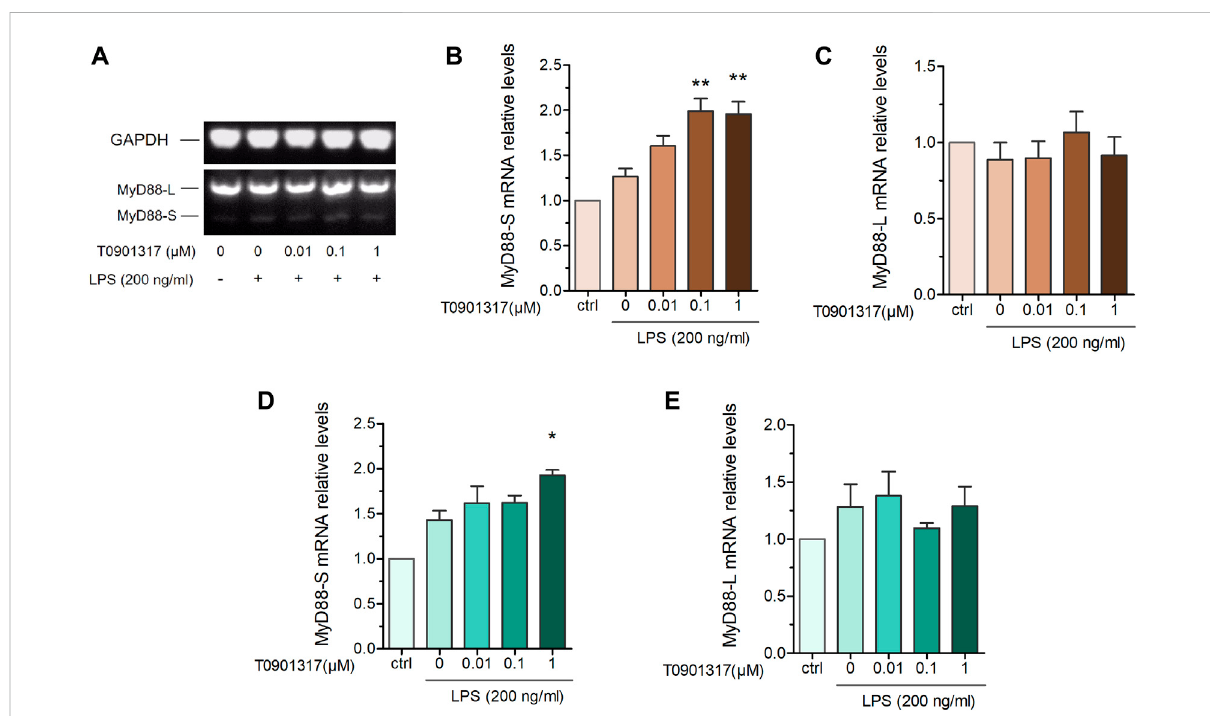
FIGURE 5 T0901317 affects MyD88 alternative splicing. RAW264.7 macrophages were pretreated with T0901317 (0, 0.01, 0.1, or 1 μ M) for 18 h, followed by stimulation with or without LPS (200 ng/mL)for 3 h (A – C) mRNA levels of MyD88-S and MyD88-L isoforms were measured by semi-quantitative RT-PCR. (D,E) mRNAlevelsofMyD88-SandMyD88-LisoformsweremeasuredbyqPCR.AllmRNAlevelswerenormalizedtoGAPDH.Similarresults were obtained in three independent experiments. Values are expressed as means ± SEM and were analyzed by one-way ANOVA. * p < 0.05, ** p <